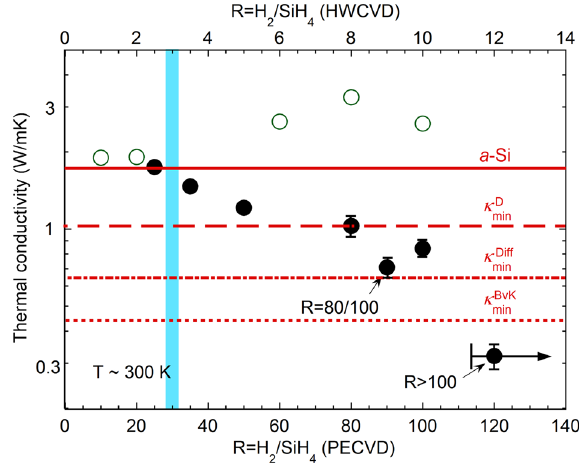
Fig. 5 The R dependence of thermal conductivity κ at ~300 K. Data of hot- wire chemical vapor-deposited (green open circle) and plasma-enhanced chemical vapor-deposited (black solid circles) nc -Si fi lms are compared. The R values for hot-wire chemical vapor deposited and plasma-enhanced chemical vapor deposited are on the top and bottom axes, respectively. The right arrow indicates the uncertainty of R for R > 100 explained in the “ Results ” section. The vertical blue bar represents the R range beyond which the fi lms become mostly crystalline. The room temperature κ of a sputtered a -Si fi lm, 0.52 μ m thick, grown at 230 °C (ref. 47 ) and the two κ κ Diff (ref. 37 ) are presented min shown in Fig. 4 and an additional diffusive min as patterned horizontal red lines. The error bars for plasma-enhanced Fig. 4 Thermal conductivity vs. temperature. The data of all seven plasma- chemical vapor-deposited nc -Si fi lms are given (unless they are smaller enhanced chemical vapor-deposited nc -Si fi lms are compared with those of than the data points), as discussed in detail in Supplementary Note fi ve hot-wire chemical vapor-deposited nc -Si fi lms 44 , and a sputtered a -Si fi lm, 0.52 μ m thick, grown at 230 °C (ref. 47 ). The computed minimum thermal conductivities, κ D (dashed red line) and κ BvK (dotted red line), min min which utilize Debye or Born-von Karman dispersion relationships, respectively, are explained in the minimum thermal conductivity section. The fi tting curve for R > 100 using the Born-von Karman dispersion relation and frequency-independent (gray) grain boundary scattering explained in the test are shown as a dashed blue line. The error bars for plasma- enhanced chemical vapor-deposited nc -Si fi lms are representative of standard deviations of thermal conductivity measurements and uncertainties in fi lm dimensions, as discussed in detail in Supplementary Note 2.